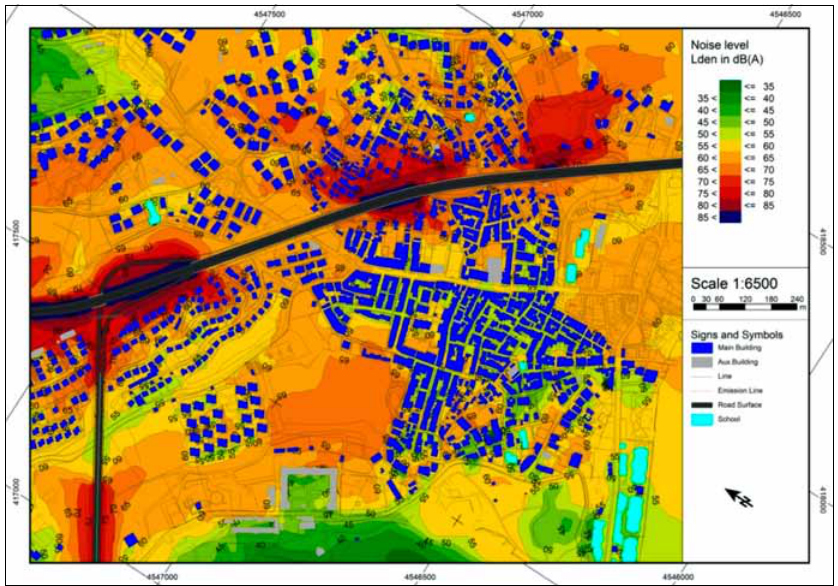
Fig. 2. Current situation noise map of the Bosporus Bridge link road for the day-evening-